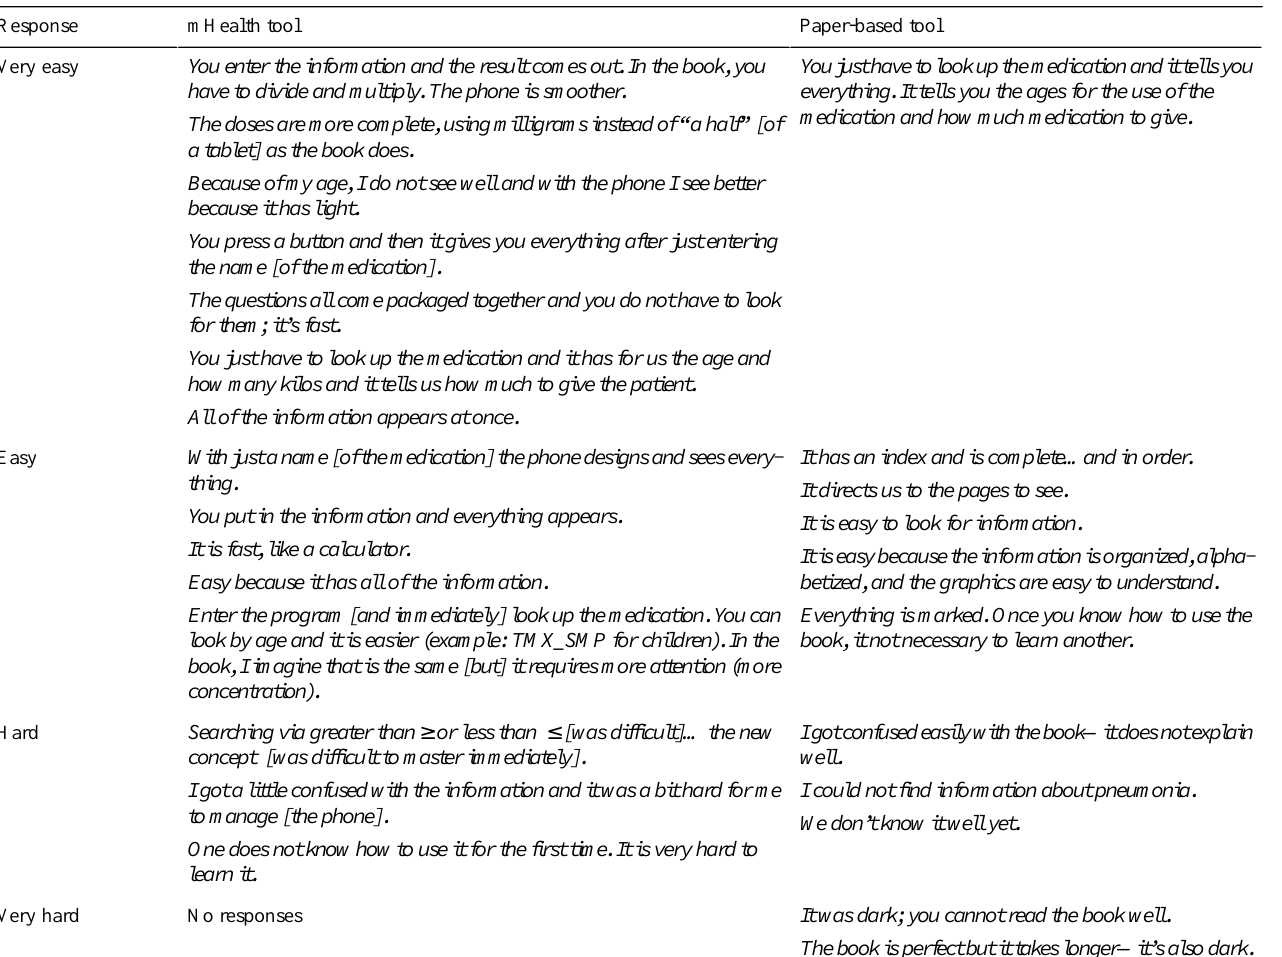
Table 2. Narrative responses about comfort/perceived ease of use of the 2 tools.